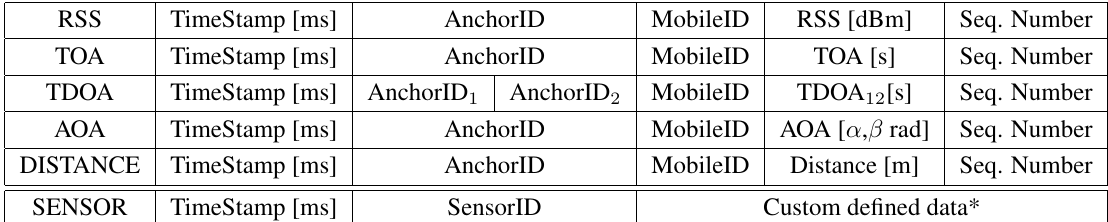
Table 1. Standardized types of measurement